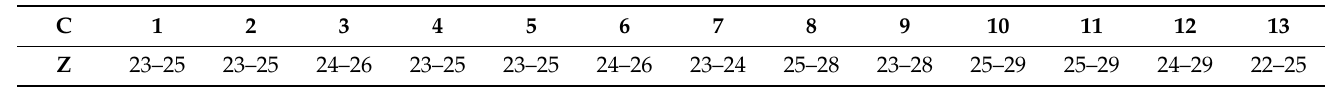
Table 16. Machine efforts recorded for the z axis, for drilling, according to the number of cycles per part.